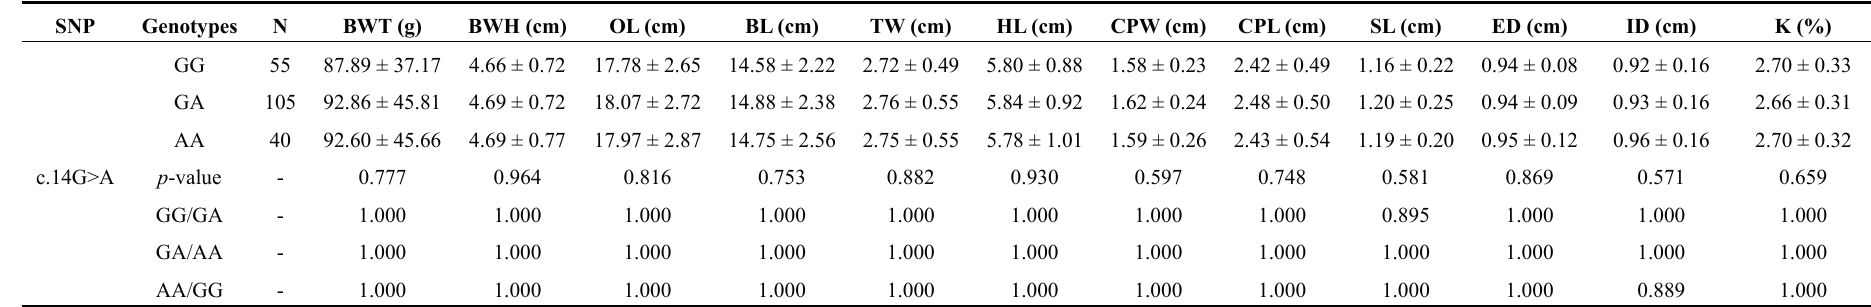
Table 2. Least squares means and standard deviations of growth traits between different genotypes of leptin-b SNPs in the orange-spotted